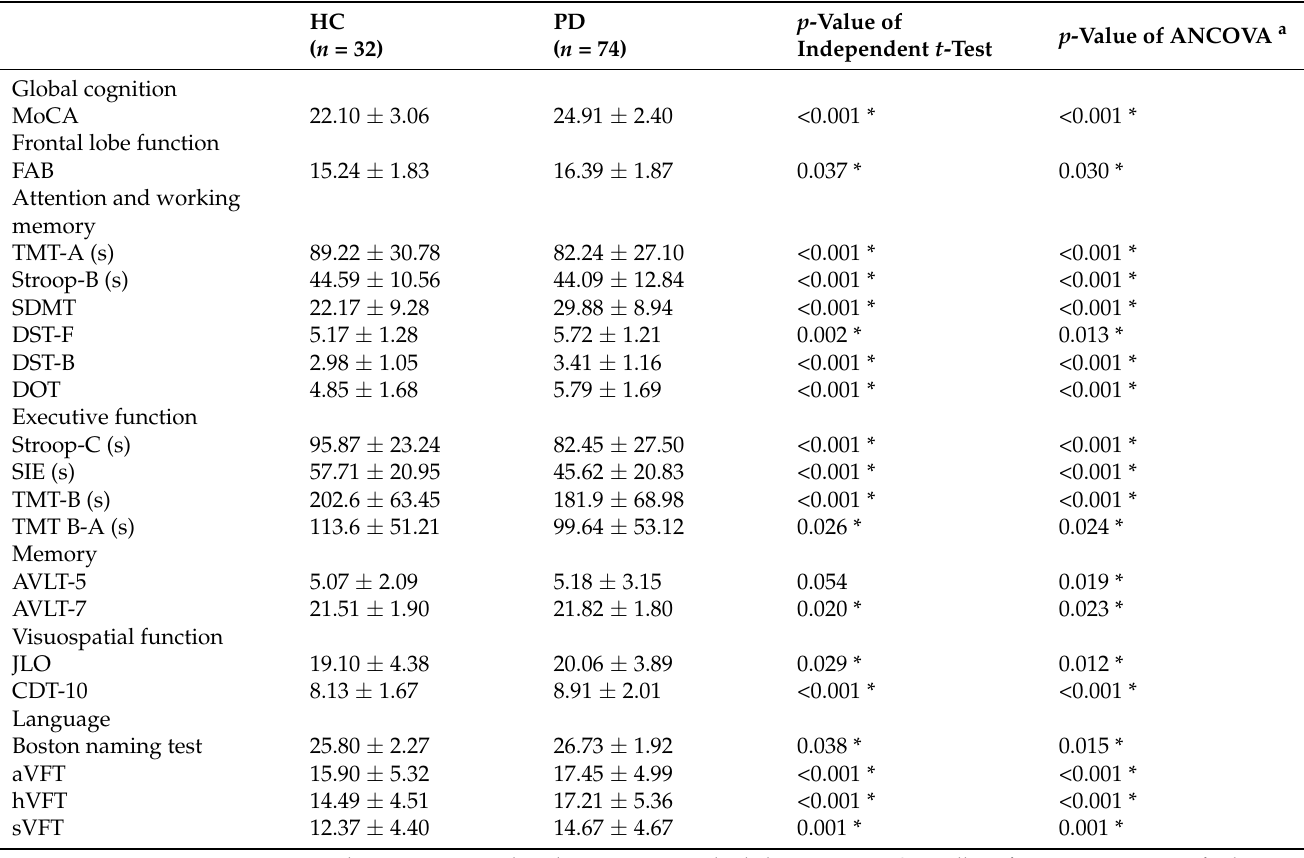
Table 2. Differences in cognitive performance between HC and PD.